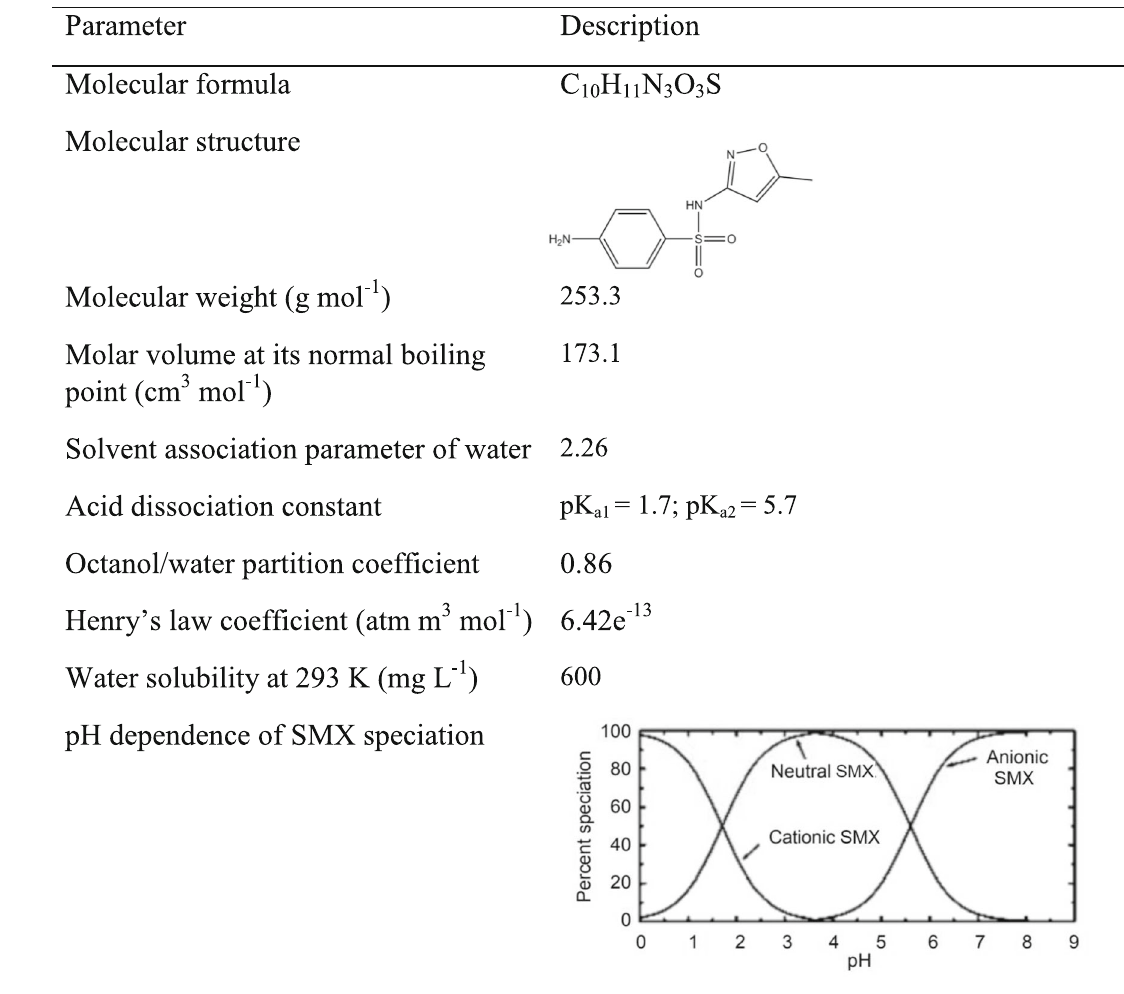
Table 1 Physicochemical properties of